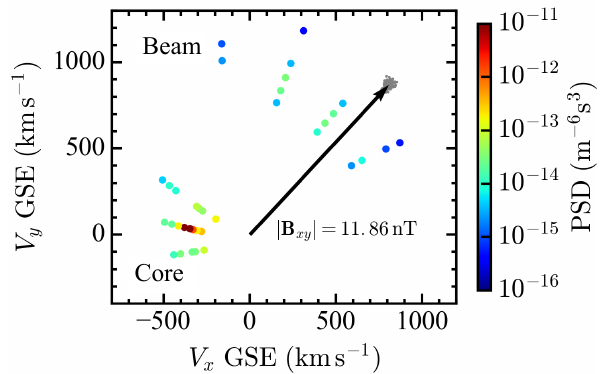
Figure 12. Coloured dots: Two-dimensional reduced ion velocity distribution in GSE coordinates measured by Geotail/LEP between 08:16:10 and 08:16:22UT. The cold solar wind core flows with V x ∼ − 400kms − 1 , and the hotter field-aligned beam propagates in the opposite direction. Black arrow: averaged magnetic field di- rection in the x – y GSE plane measured by Geotail/MGF during the interval. Grey dots: all individual Geotail/MGF measurements taken at 8Hz cadence. The stability of the orientation of the magnetic field is